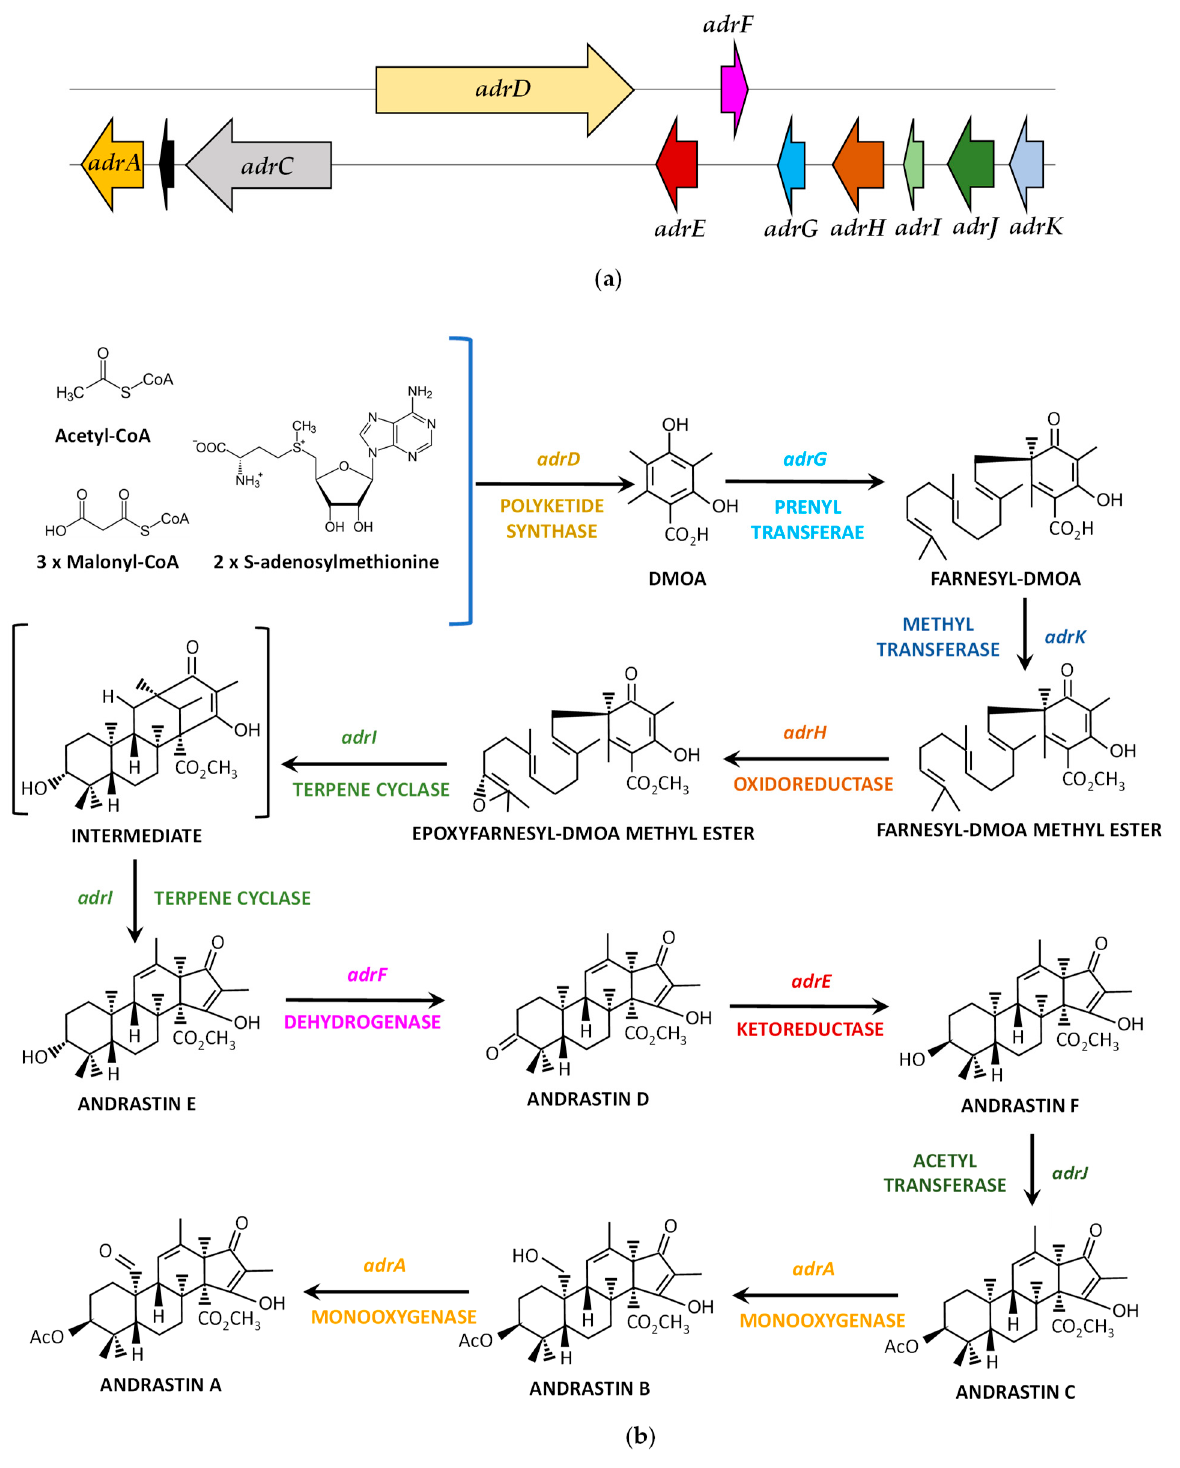
Figure 6. Biosynthesis of Andrastin A: ( a ) Andrastin A biosynthetic gene cluster in P. roqueforti . The pseudogene is indicated as a black box; ( b ) Proposed biosynthetic pathway for Andrastin A in P. chrysogenum . Likely, this pathway is similar in P. roqueforti . DMOA (3,5-dimethylorsellinic acid). Adapted from [71,72].